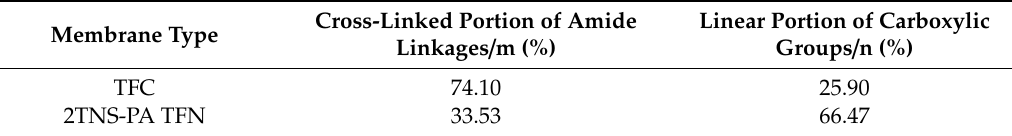
Table 2. Chemical structure of the repeating unit aromatic